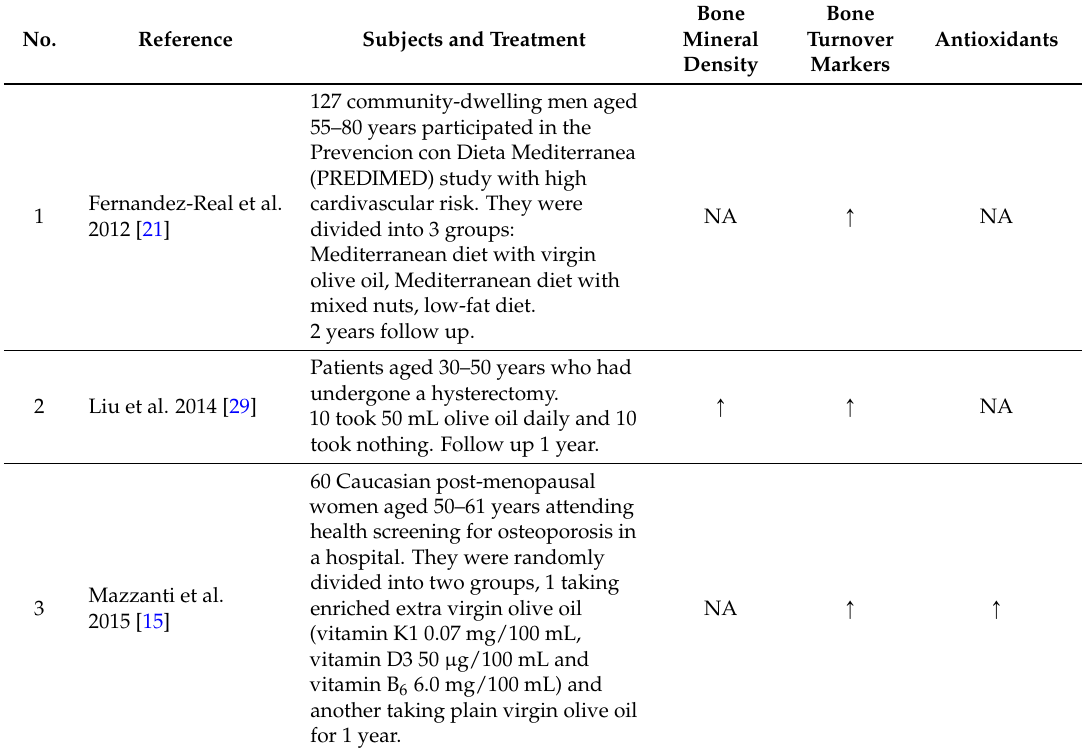
Table 2. Human studies on the bone protective effects of olive